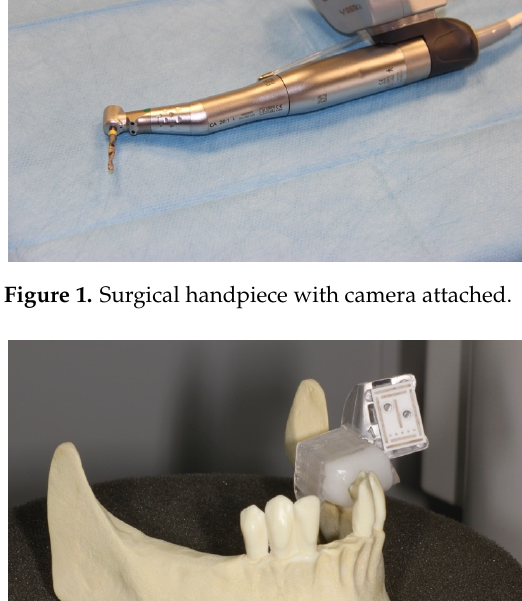
Figure 3. Implementing implantation under standardized laboratory conditions. Each drill, including the implant, was automatically registered with a registration instrument before its use (Figure 4). Each drill was inserted in the surgical contra-angle handpiece and placed in a registration block with the marker for automatic registration. The dimensions of the drill were measured. This measurement was compared to the man- ufacturer’s specifications. This procedure was performed each time the drill was changed to provide a system with precise information on the length and diameter of the drill being used.